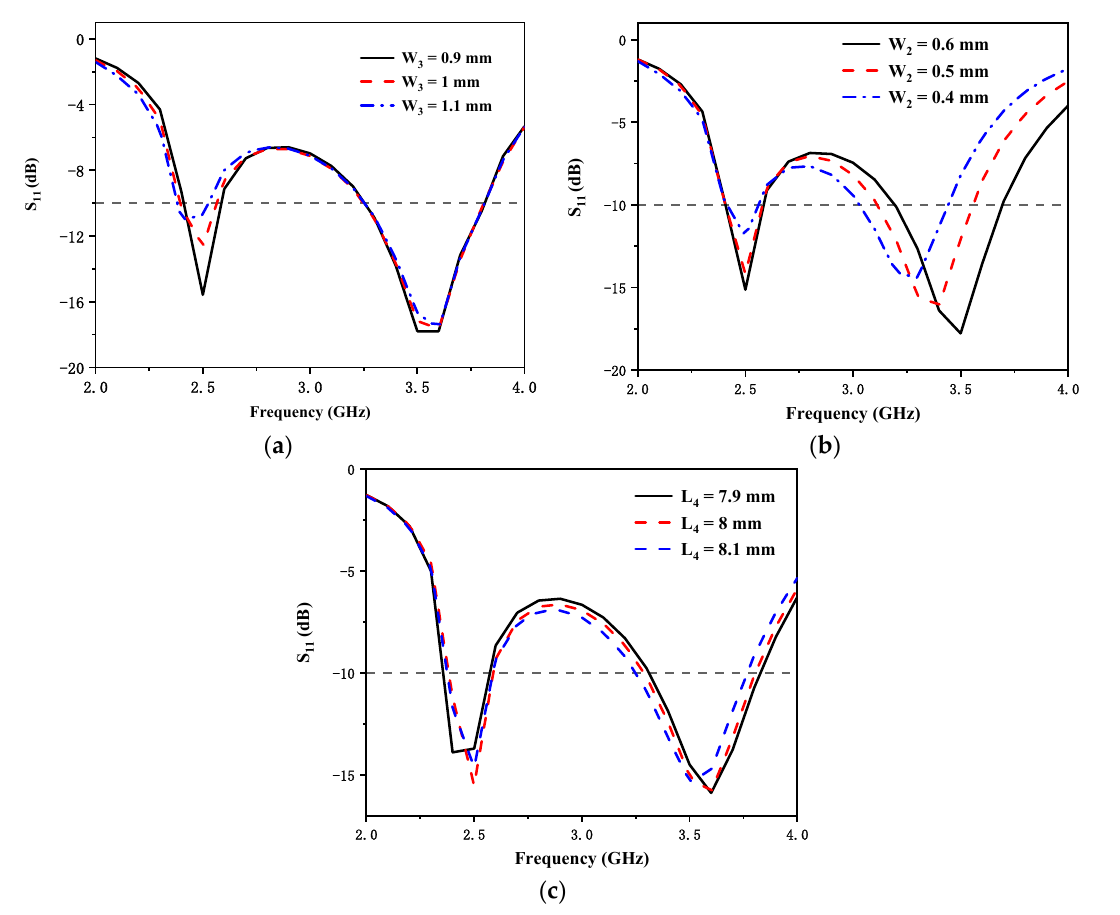
Figure 4. Simulated reflection coefficients for different values of ( a ) W 3 ; ( b ) W 2 ; ( c ) L 4 . Table 1. Dimensions of the proposed antenna (unit: mm).